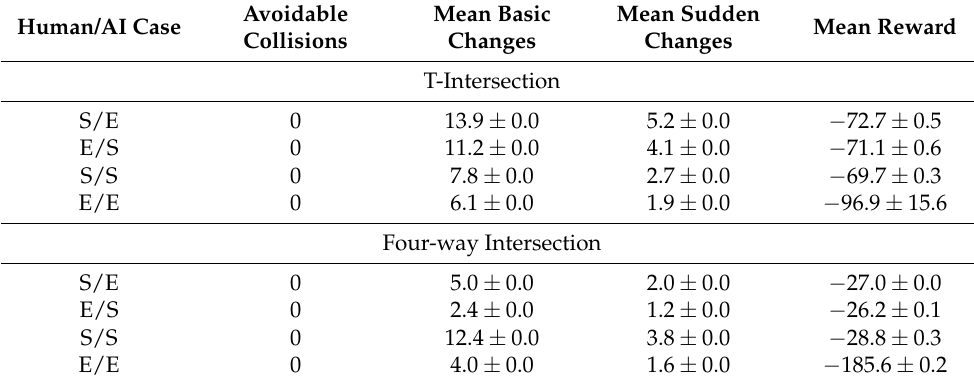
Table 15. Human: noisy weather, AI: sensor and mask. Test results for manager performance and